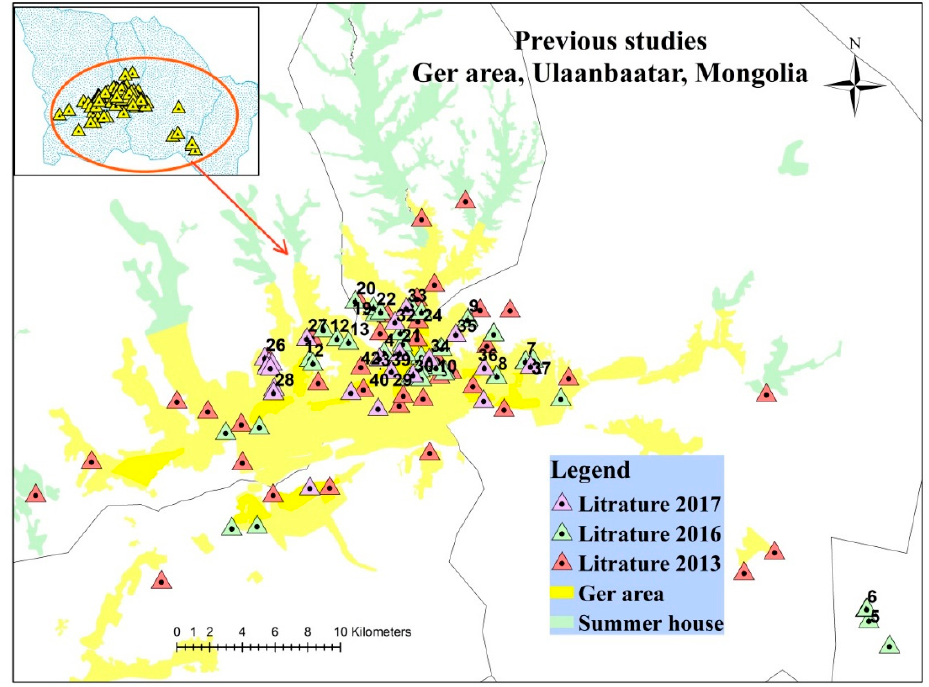
Figure 2. Location of sites in the previous studies and the selected 42 sites.